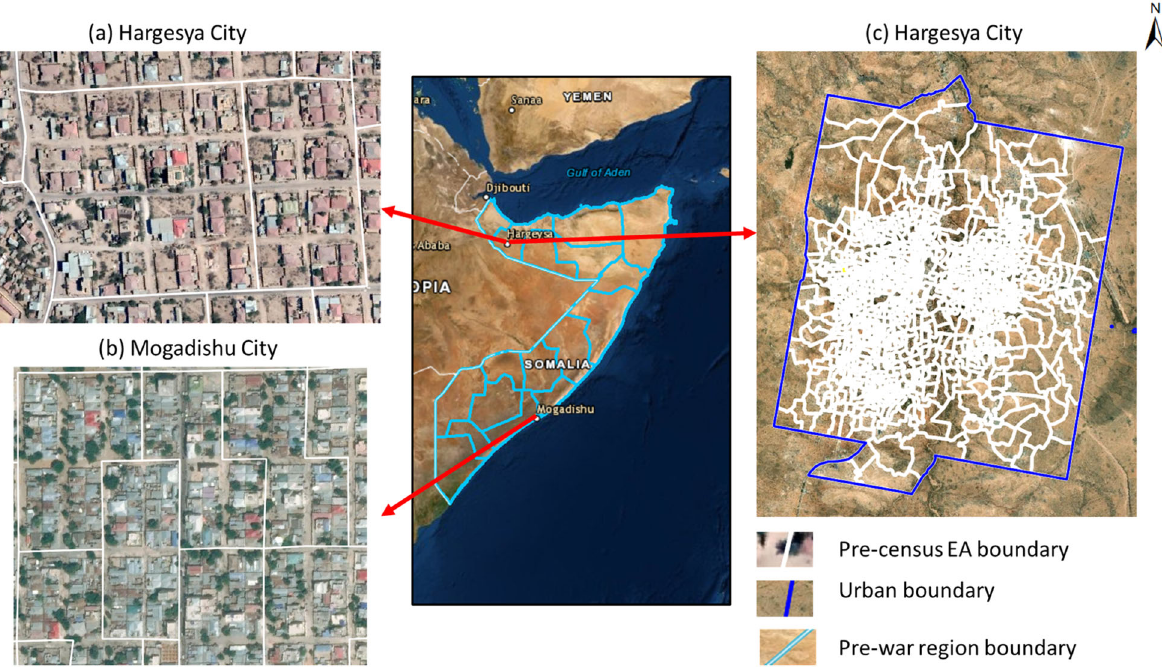
Fig. 6 Outlines of semi-automated urban EAs in different locations over Hargeysa and Mogadishu in Somalia. a , b The automated urban EA boundaries are matching well with ground roads and they are nested within urban strata ( c ).